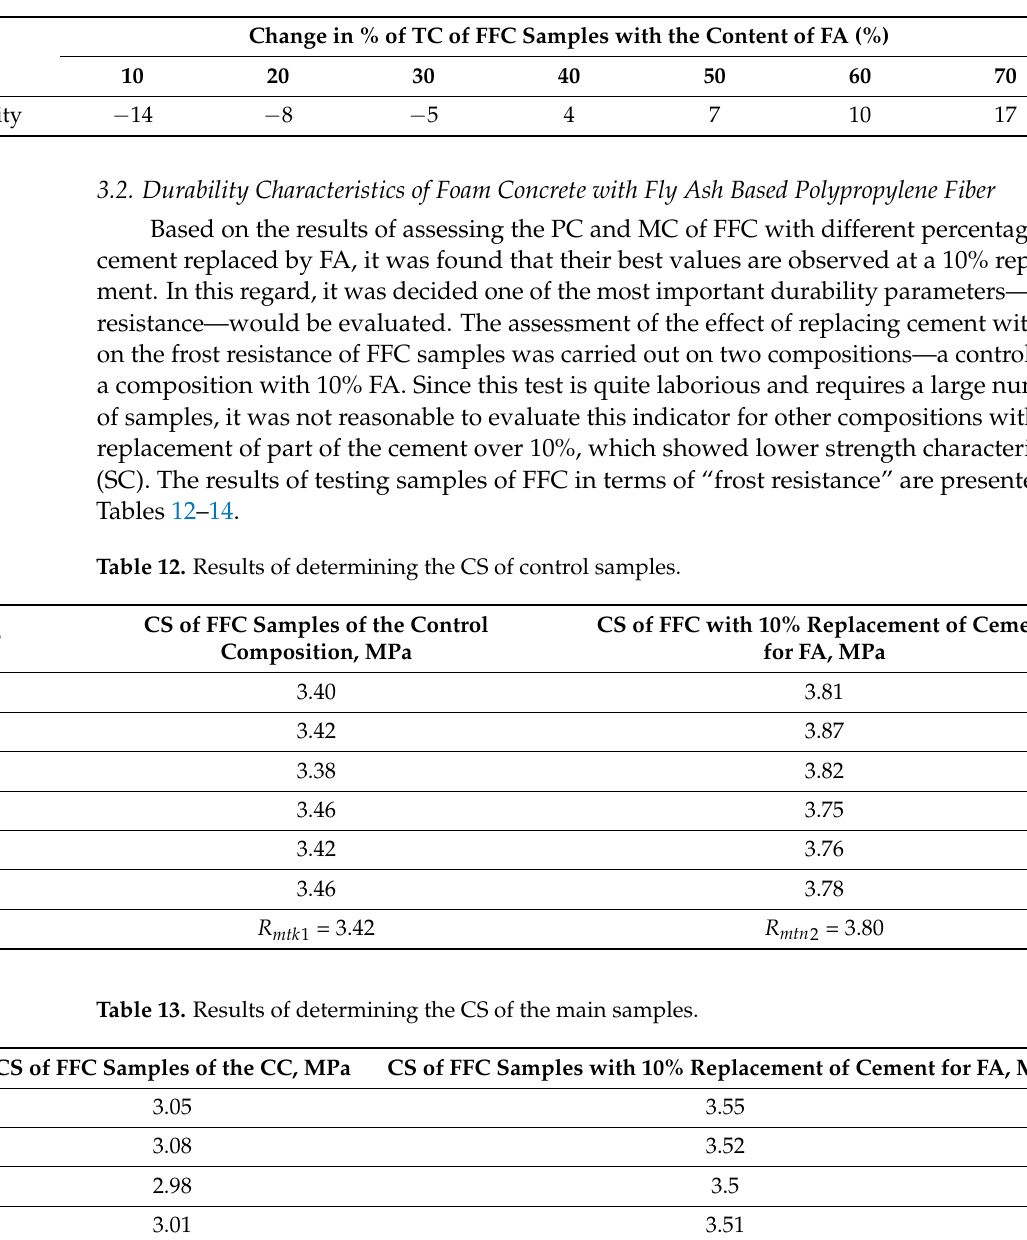
Table 11. Change in the TC of FFC samples depending on the percentage of FA.